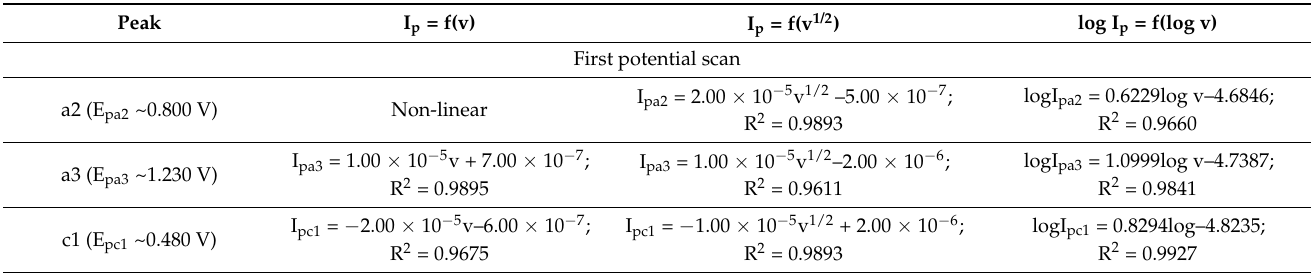
Table 2. The data obtained from the cyclic voltammograms (Figure 5) recorded for HESP at H type PGE; peak current (I p , A) and potential scan rate (v,